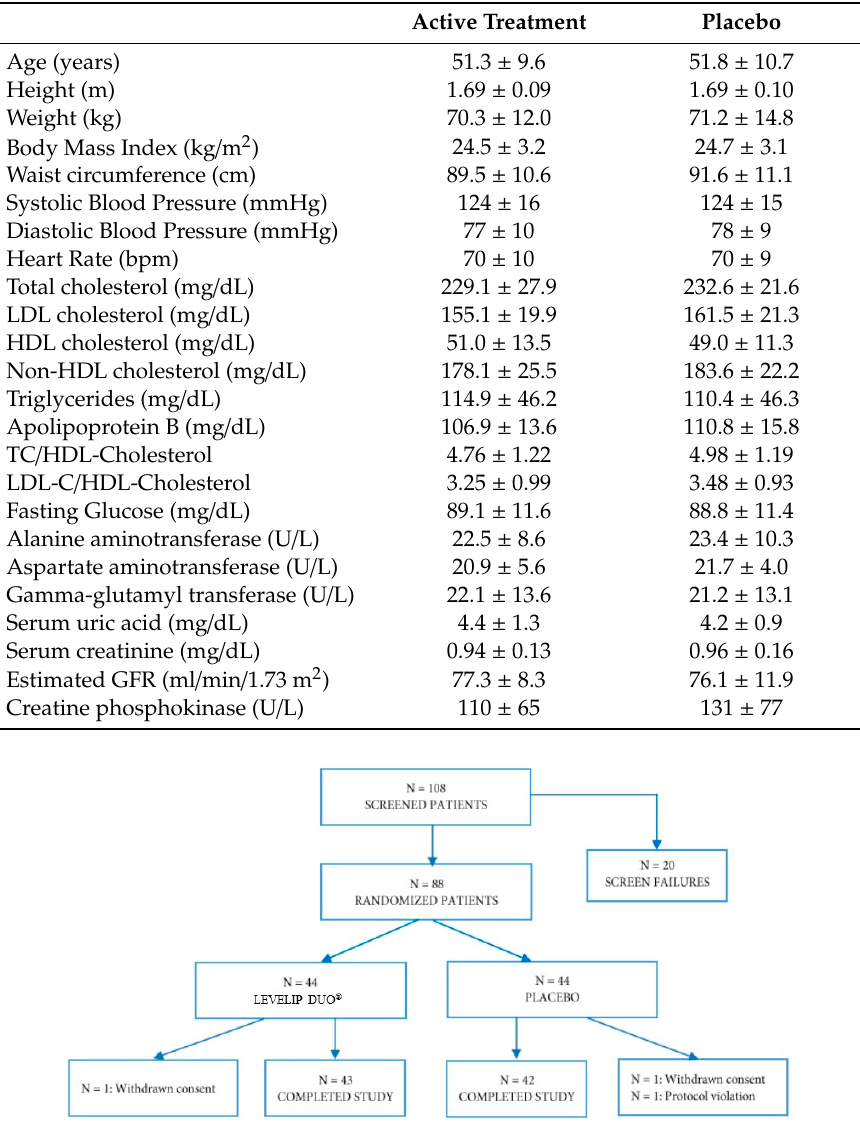
Table 1. Baseline characteristics of the enrolled subjects: non-statistically significant di ff erence has been detected between the treatment groups (values reported as mean ± standard deviation; No significant di ff erence between groups has been observed).